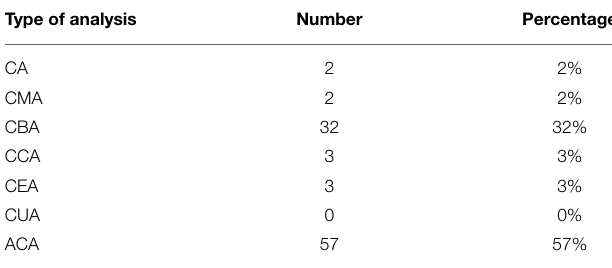
TABLE 3 | Types of economic evaluation of the reviewed